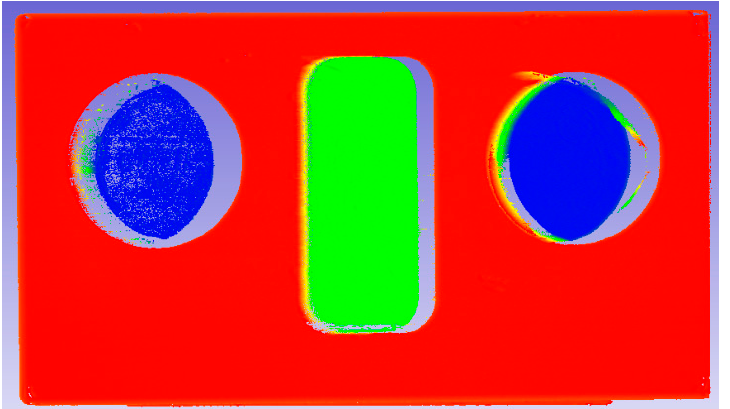
Figure 9. Point cloud data in the coordinate system of the self-rotating, LSL scanning, 3D reconstruction when M = 123 and N = 409.